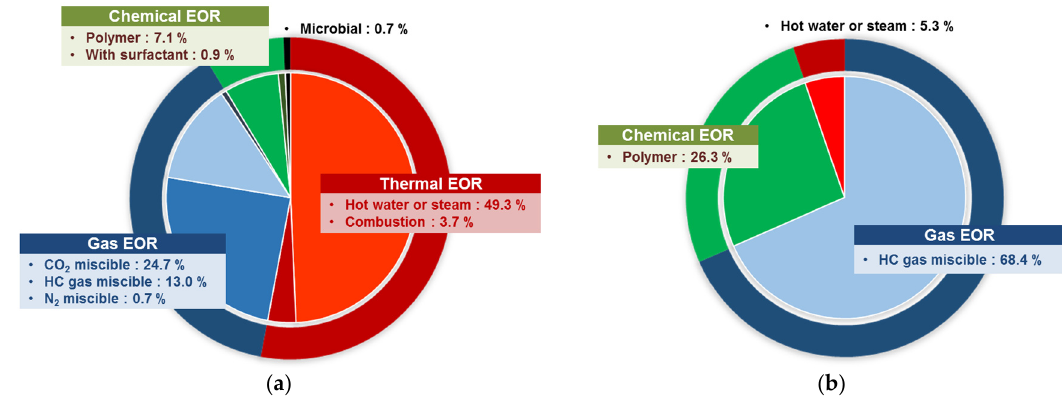
Figure. 3. Successful EOR cases in onshore and offshore fields. ( a ) Onshore cases; ( b ) Offshore cases.